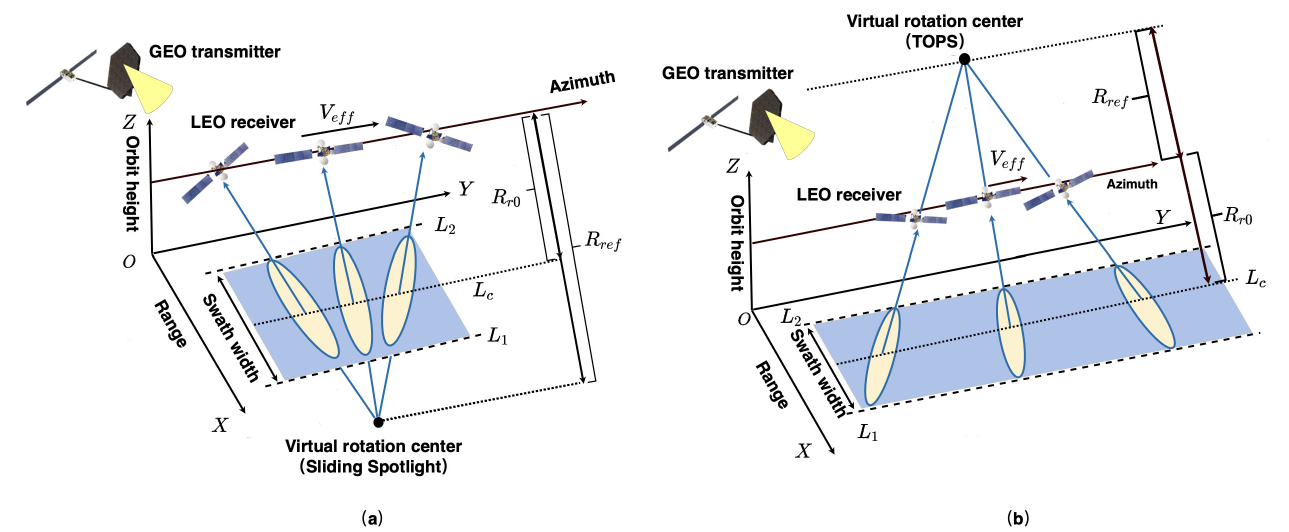
Figure 2. Data Acquisition of the GTLR-BiSAR System (not scaled). ( a ) Data Acquisition of the SS mode. ( b ) Data Acquisition of the TOPS